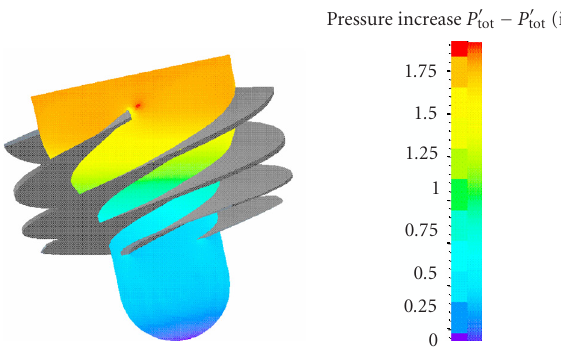
Figure 4: View of the mesh on hub side of the inducer (the entire inducer geometry is reconstructed by rotation of a single blade-to- blade channel).